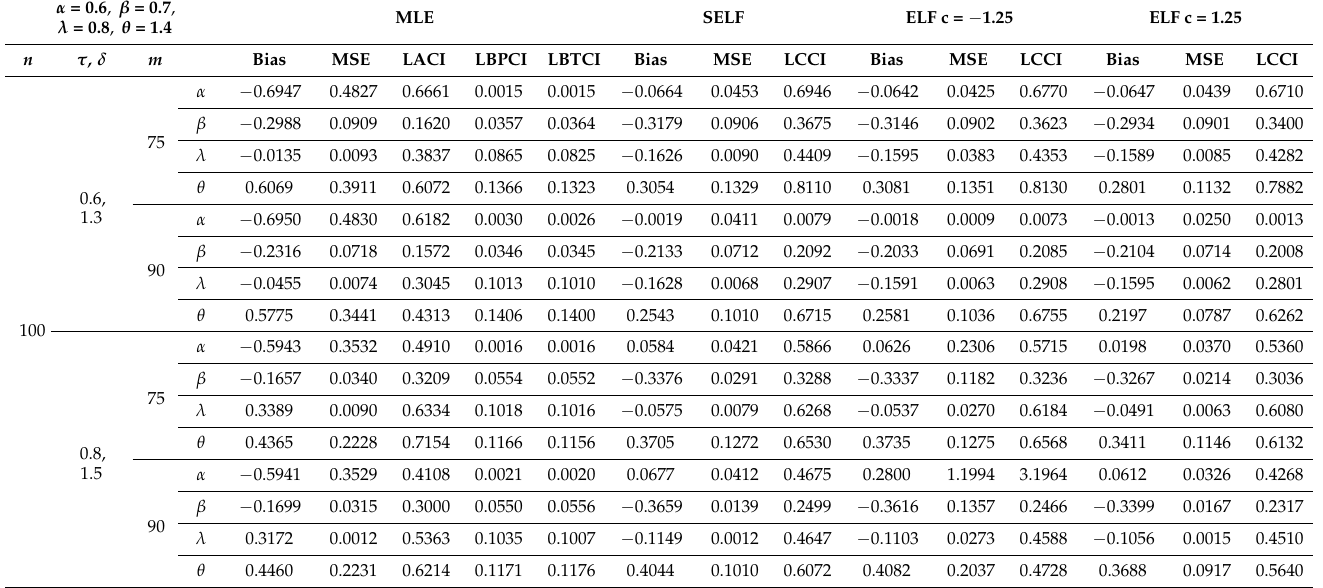
Table 5. Bias, MSE, LACI, LBCI, and LCCI with scheme 2 in case